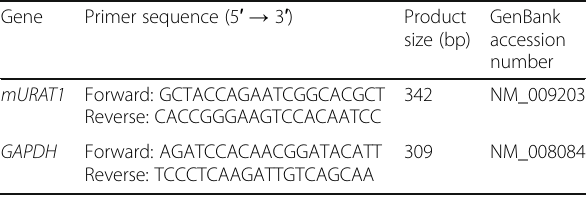
Table 2 Primers and expected sizes of polymerase